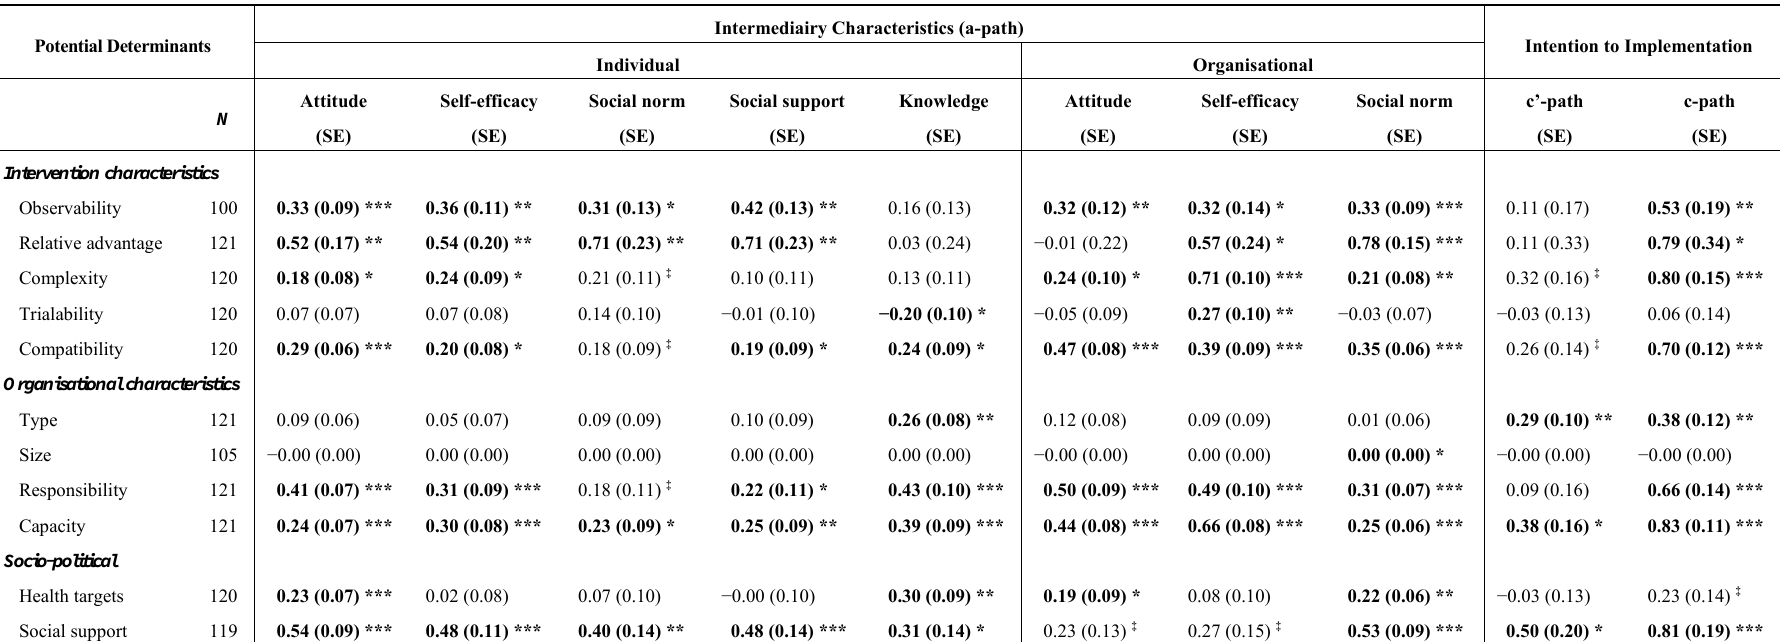
Table 3. Association between distal factors and proximal factors (a-path), and the association between distal factors and intention (with (c’-path) and without correction (c-path) for the proximal